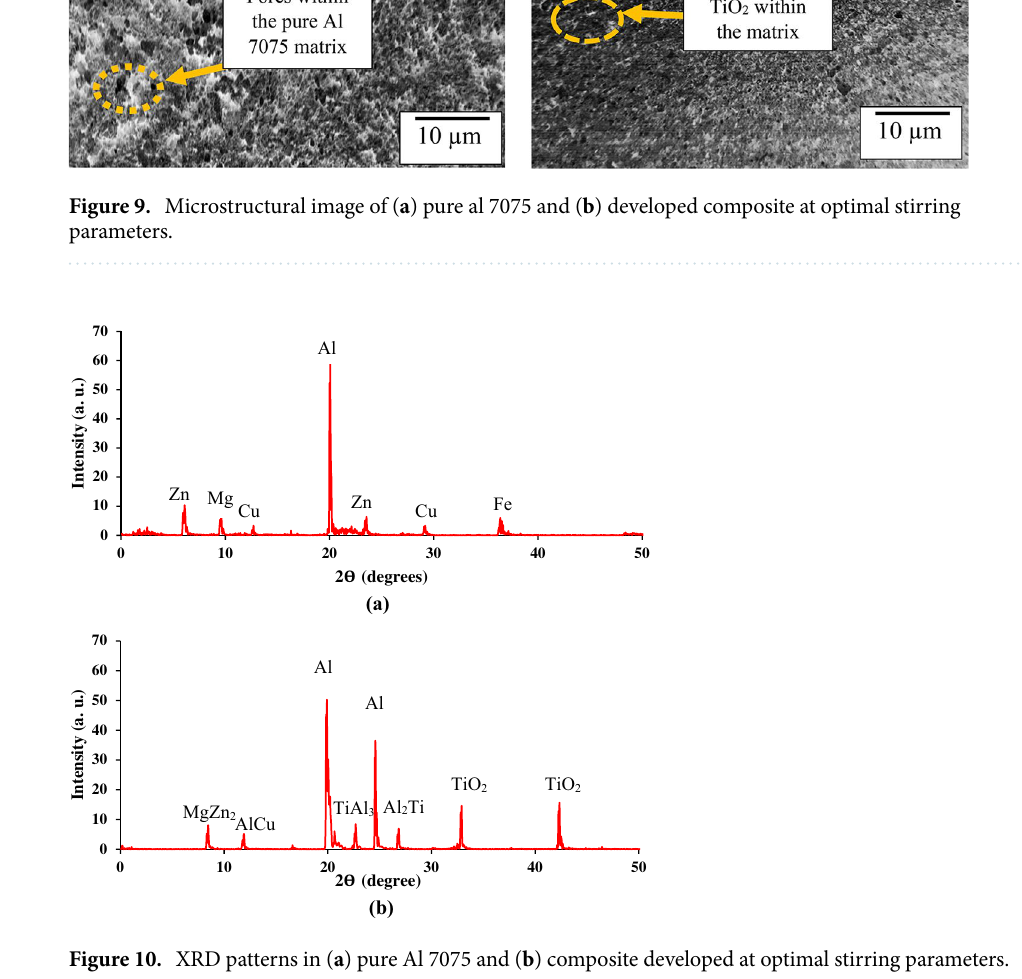
Figure 10. XRD patterns in ( a ) pure Al 7075 and ( b ) composite developed at optimal stirring